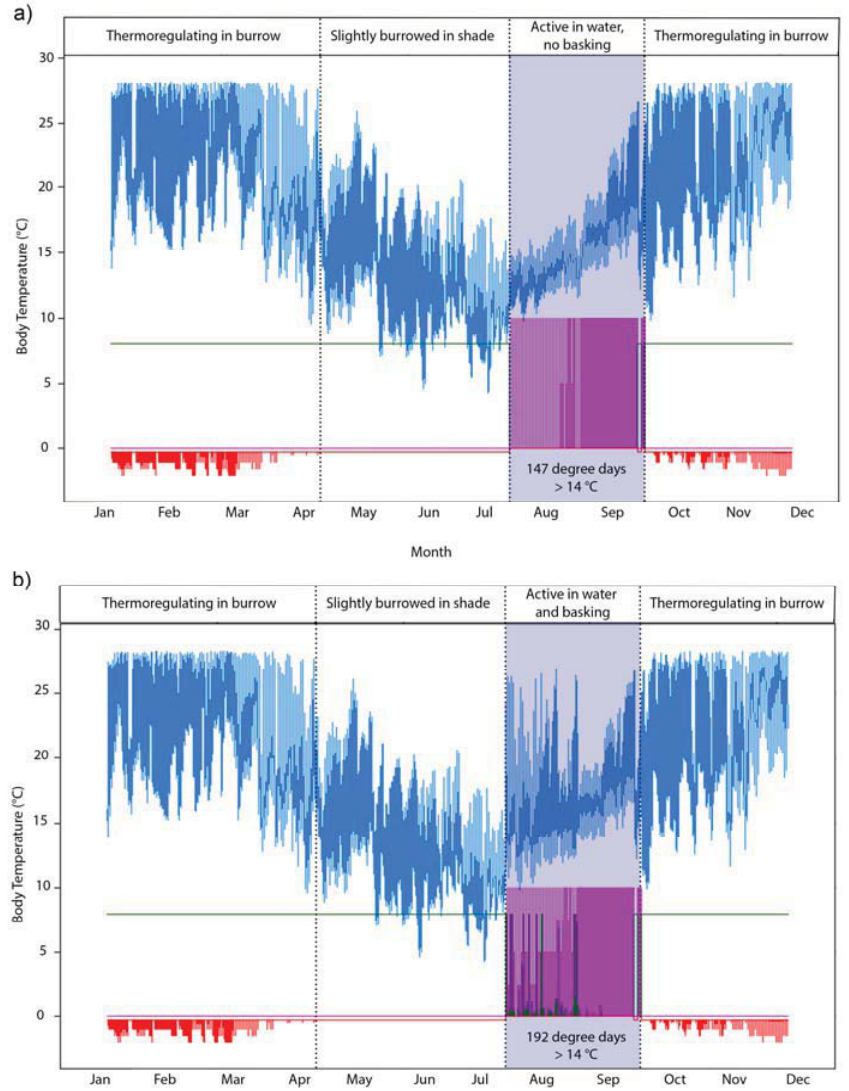
Figure 3. Examples of three simulations of tortoise body temperatures and activity potential at Ellen Brook Nature Reserve using AWAP climate data for 2006 when low winter rainfall severely restricted the swamp hydroperiod (grey shading). Blue lines depict the body temperature (°C) of a tortoise, pink indicates that the tortoise in is water, green indicates selected shade (10 = 100%) and the red panel shows the depth (cm) of the microclimate selected by the tortoise during the aestivation period. The behavioral routines in NicheMapR cause a tortoise to select a microhabitat that maintains its body temperature below its voluntary thermal maximum of 28 °C (Table 2). At high environmental temperatures the tortoise aestivates and thermoregulates by seeking cooler microhabitats in burrows in up to 80% shade. At lower environmental temperatures the tortoise aestivates just below the surface and ceases to thermoregulate. The tortoise then selects an aquatic environment once the wetland water depth is at least 5cm. ( a ) depicts a scenario where the simulated tortoise was prevented from basking, ( b ) demonstrates a more natural scenario where the tortoise was able to raise its body temperature above its voluntary minimum through ambient basking, while ( c ) presents a hypothetical scenario where basking is maximized ( i.e. , simulated tortoises preferentially bask rather than